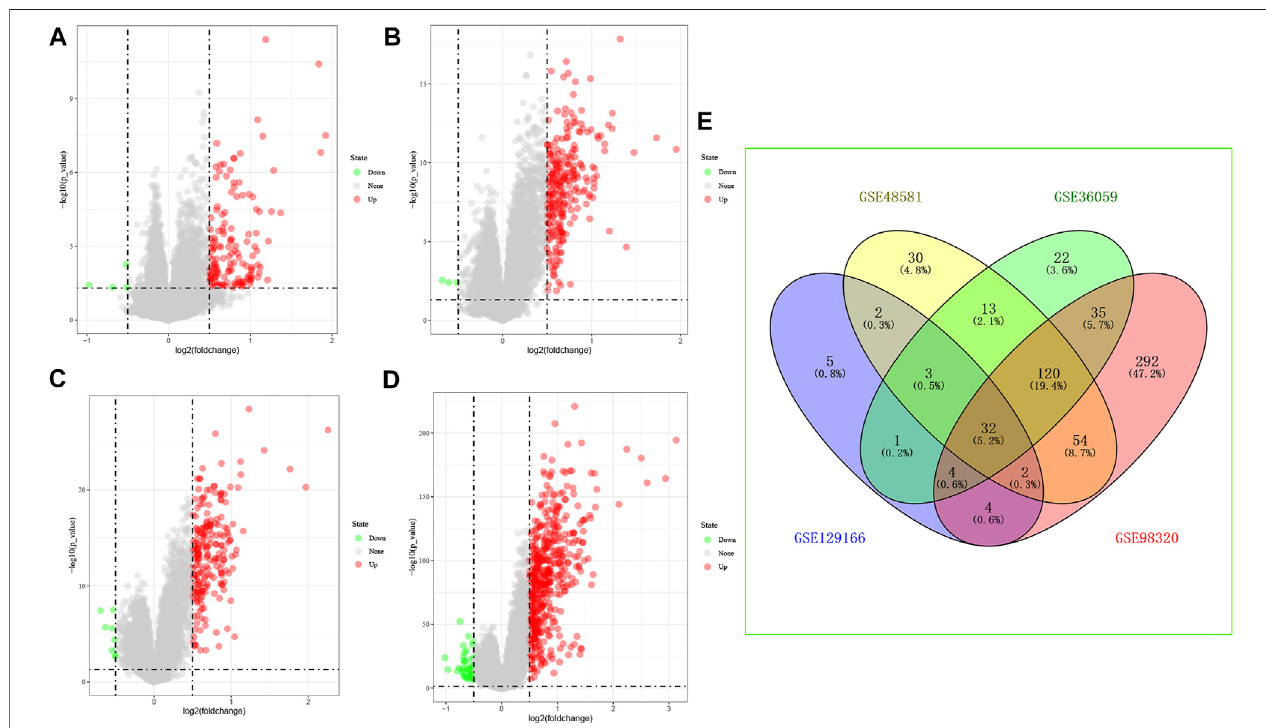
FIGURE 1 | Differential gene expression, (A) : GSE129166 (B) : GSE48581 (C) : GSE36059 (D) : GSE98320 (E) : Common differential gene expression of the four data sets. (A – D) : Red represents up-regulated differential genes, green represents down-regulated differential